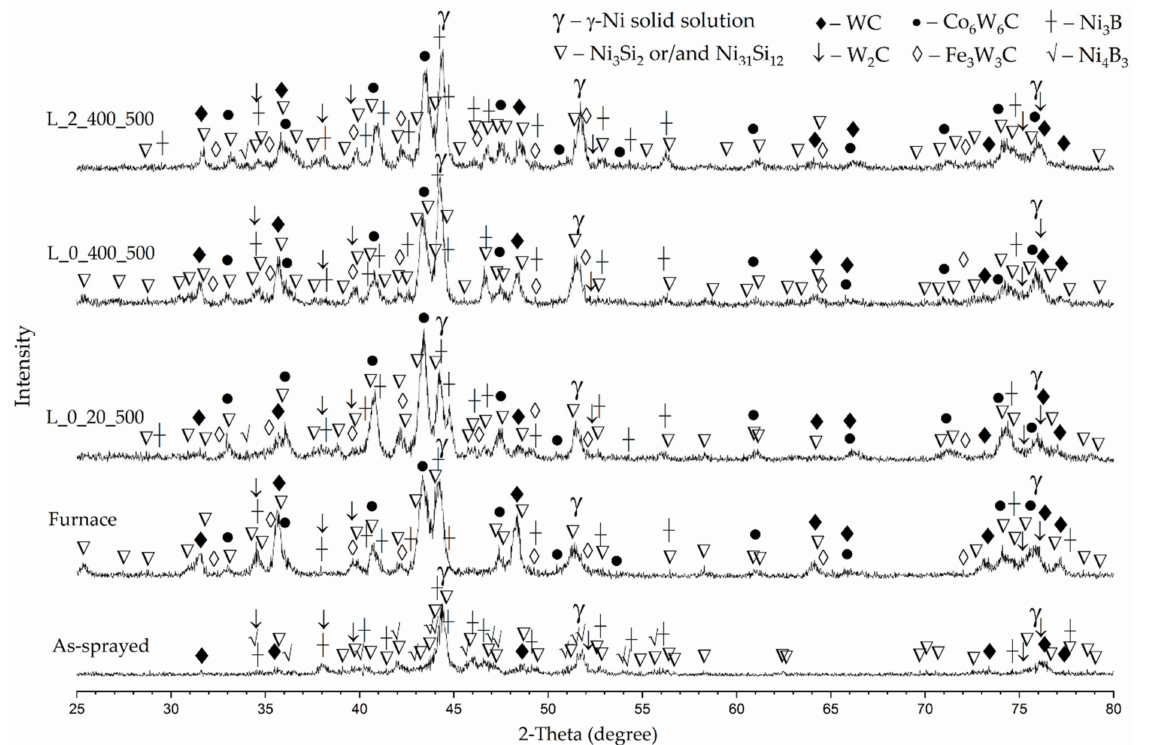
Figure 11. XRD patterns of the as-sprayed coating, coating remelted in furnace and laser post- processed coatings (L_0_20_500; L_0_400_500; L_2_400_500); L_0_20_500—laser processing without oscillation and preheating at a laser speed 500 mm/min; L_0_400_500—laser processing without oscillation with preheating to 400 ◦ C at a laser speed 500 mm/min; L_2_400_500—laser processing with oscillation amplitude A = 2 mm with preheating to 400 ◦ C at a laser speed 500